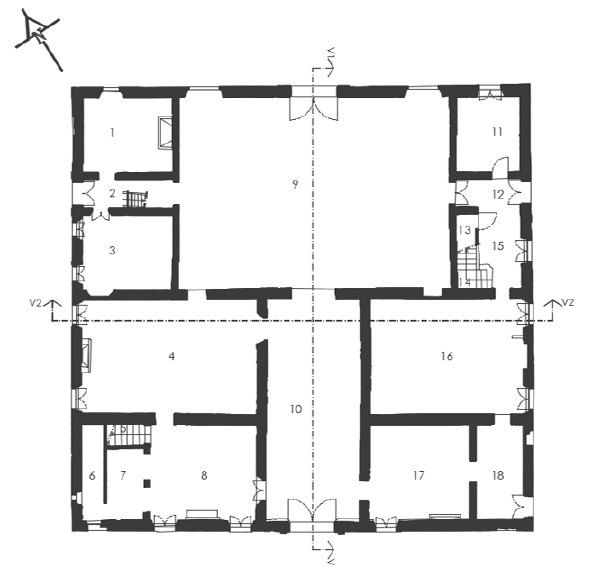
Figure 2: Ground floor plan H1 obtained from the points cloud (Municipality of Mantua).